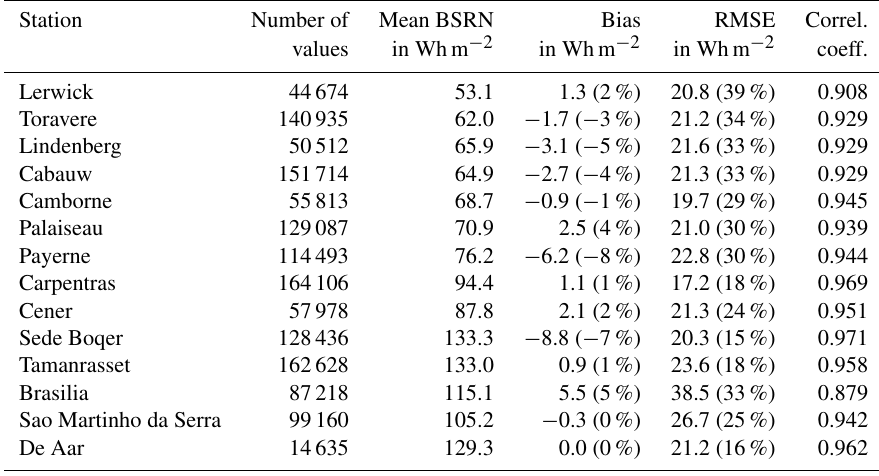
Table A1. Validation results for the 15min GHI for a temporal horizon of 15min. In parentheses, relative values.